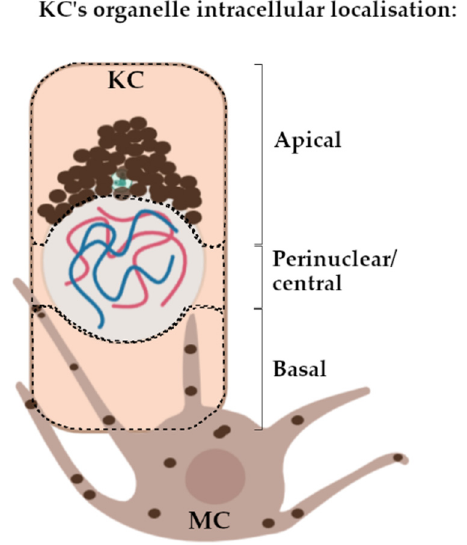
Figure 6. Methodology for assigning apical, perinuclear/central or basal subcellular localisation of KC’s organelles (i.e., melanin granules, PCNT and PCM1) in the S. basale . KC, keratinocyte; MC, melanocyte.